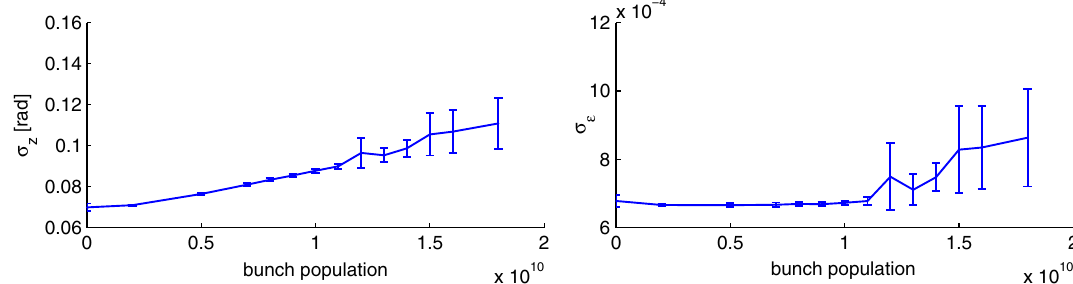
FIG. 9. rms bunch length (left) and energy spread (right) obtained with M U S I C with a broadband resonator impedance as a function of bunch